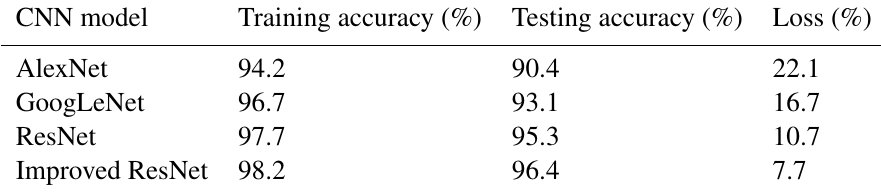
Table 4 The training and testing results of dataset2 of different CNN